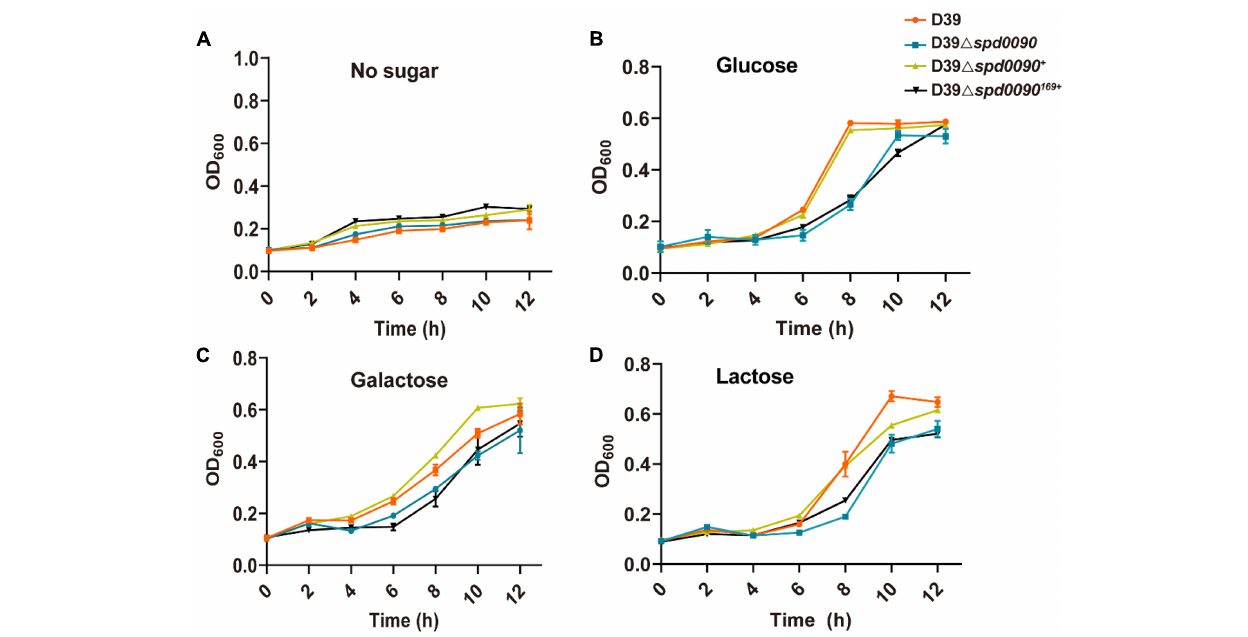
FIGURE 3 | The deletion of spd _ 0090 gene affects the growth of S. pneumoniae. (A–D) Growth curves of D39 (red), D39 (cid:49) spd0090 (blue), D39 (cid:49) spd0090 169 + (black), and D39 (cid:49) spd0090 + (yellow) strains cultured in C + Y medium containing no sugar, glucose galactose, and lactose. N = 3, each group of experiments was repeated three